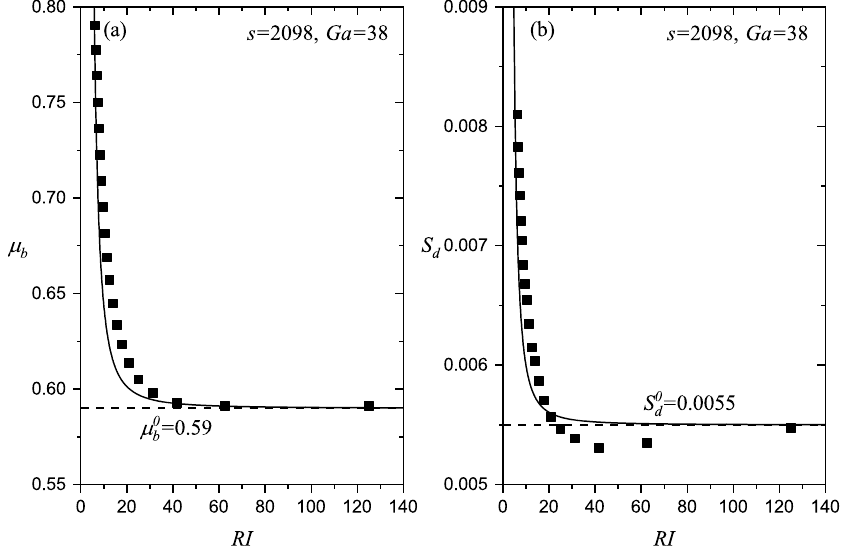
Figure 8. µ b ( a ) and S d ( b ) decrease with ripple index. Dashed lines represent their values at flat surface. Solid lines represent the results derived from Equations (21) and (22), respectively. All the results are corresponding to the cases with s = 2098 and Ga =